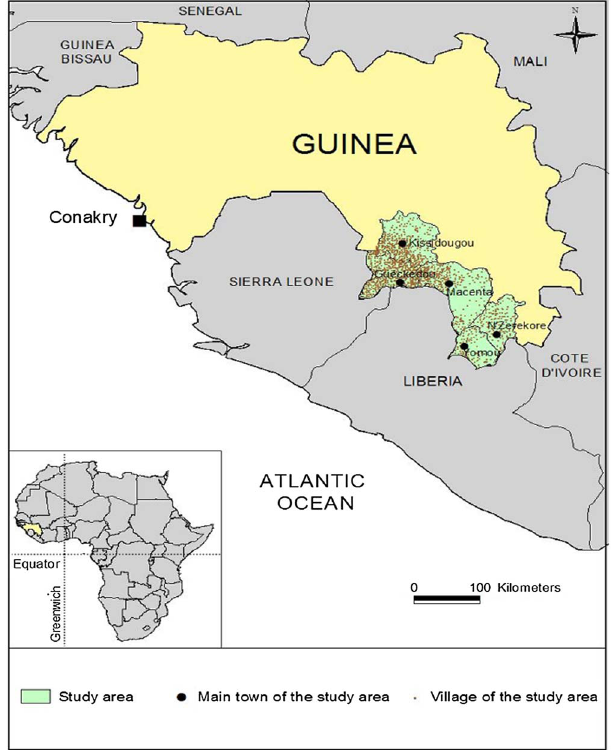
Figure 1. Location of the study area. The map displays the location of the study area, including the fi ve main towns (Kissidougou, Guéckédou, Macenta, Yomou, and N ’ Zerekore) and all of the